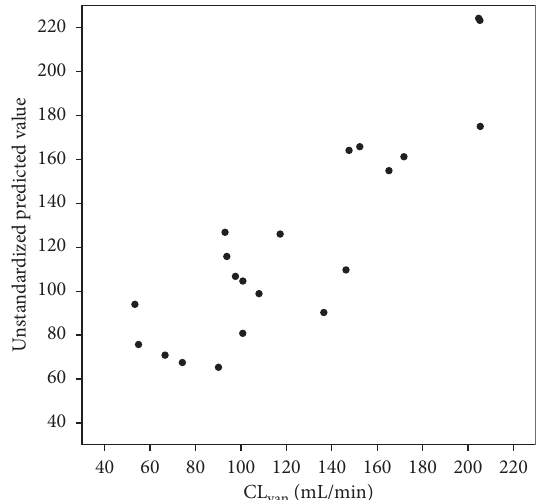
Figure 2: Correlation between predicted values of CL values. Abbeviations: CL van : clearance of